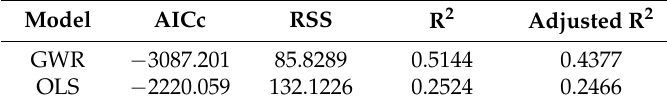
Table 1. Statistics of model fitting for GWR and OLS models.